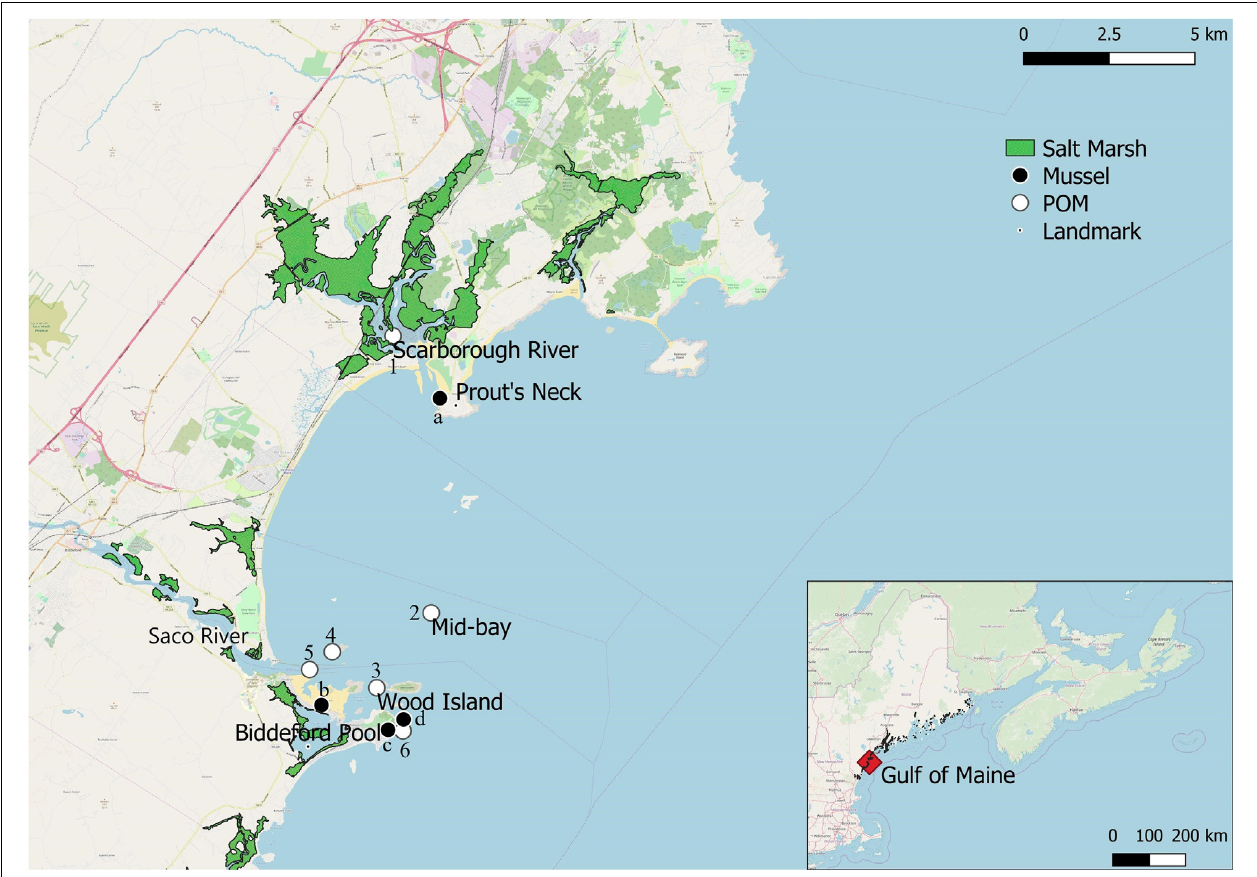
FIGURE 1 | Map of Saco Bay, ME, United States, including location of fringing salt marshes, particulate organic matter (POM) sampling sites (1: Scarborough River, 2: Mid-bay, 3: Wood Island, 4: Ram Island, 5: Saco River, 6: East coast), and sampling sites for mussels ( Mytilus edulis; a: Scarborough, b: Hill’s beach, c: East coast, d: Wood